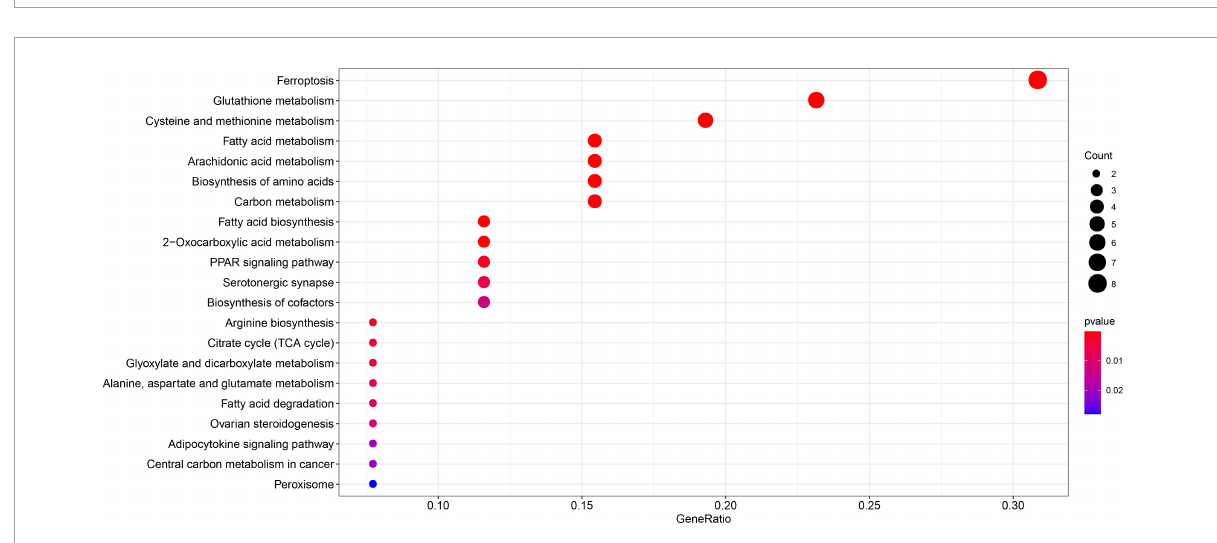
FIGURE4 Kyoto encyclopedia of genes and genomes enrichment of 29 differential FRGs. The count shows the number of genes enriched in the pathway. Gene ratio: the ratio of the FRGs number in this term to the total number of FRGs.